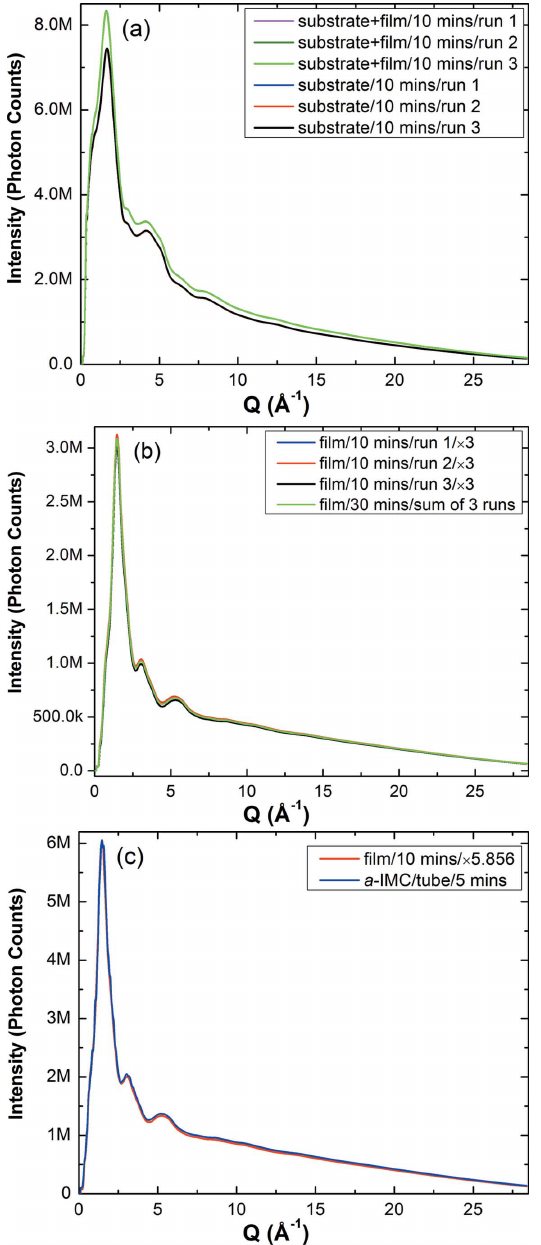
Figure 2 ( a ) Raw diffraction intensities for the thin-film sample including the substrate and for the substrate itself. ( b ) Diffraction intensities for the thin film only from four independent measurements. The 10 min runs were scaled to compare with the 30 min run. ( c ) The scattering signals for a -IMC from the tube (blue) and the thin-film (red) methods. The thin-film signal was scaled to match the signal from the tube method.